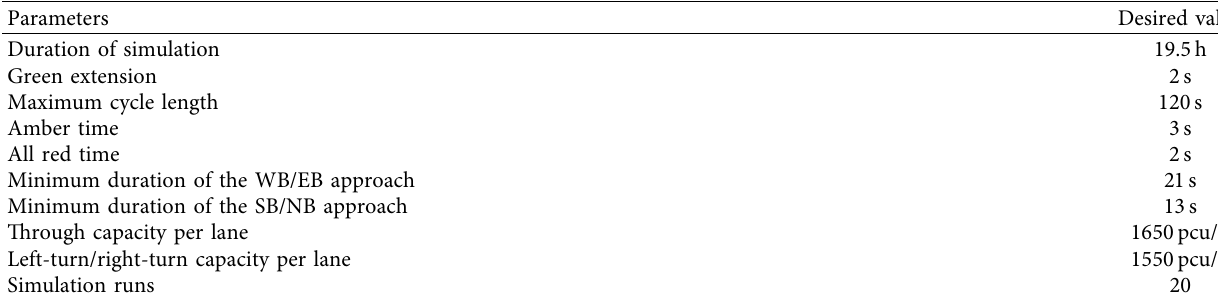
Table 8: Simulation parameters.